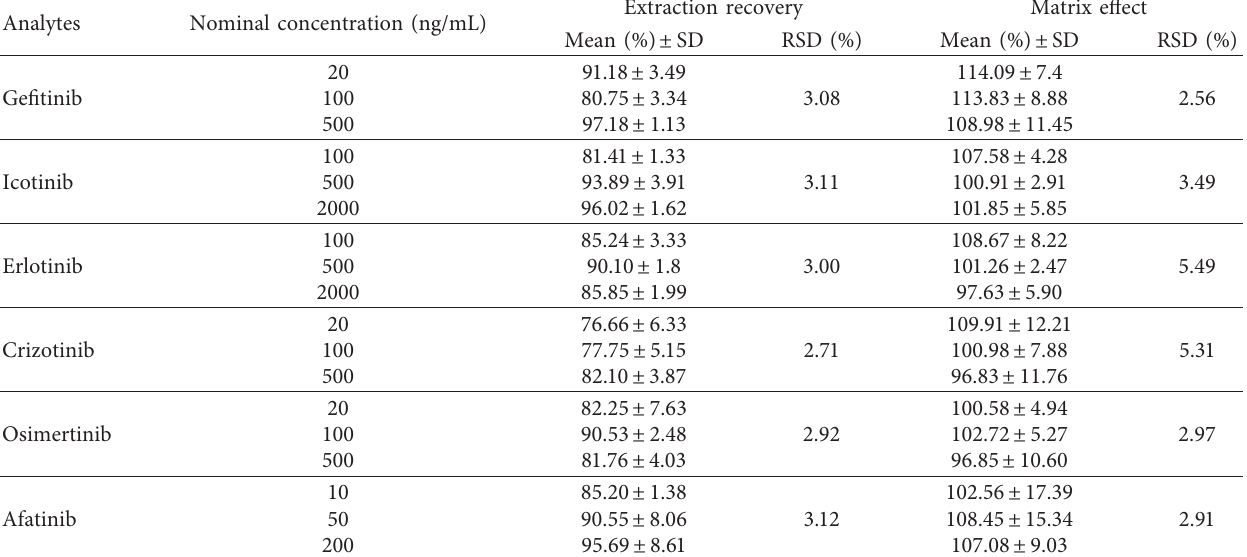
Table 4: Extraction recovery and matrix effect of six analytes (%) ( n � 3).